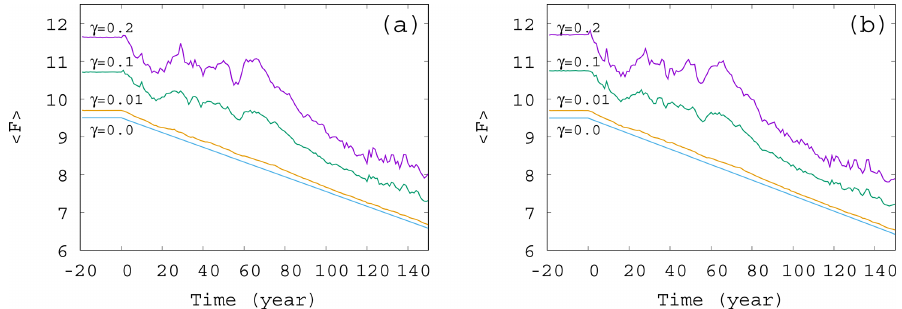
Figure 3. Time dependence of the ensemble-averaged atmospheric forcing < F > ( t ) = F ( < c > ( t ) ,t ) in the case of γ = 0 , 0 . 01 , 0 . 1, and 0 . 2 for (a) α = 0 . 05 and (b) α = − 0 . 05. The slope of the blue line for γ = 0 corresponds to D in Eq.